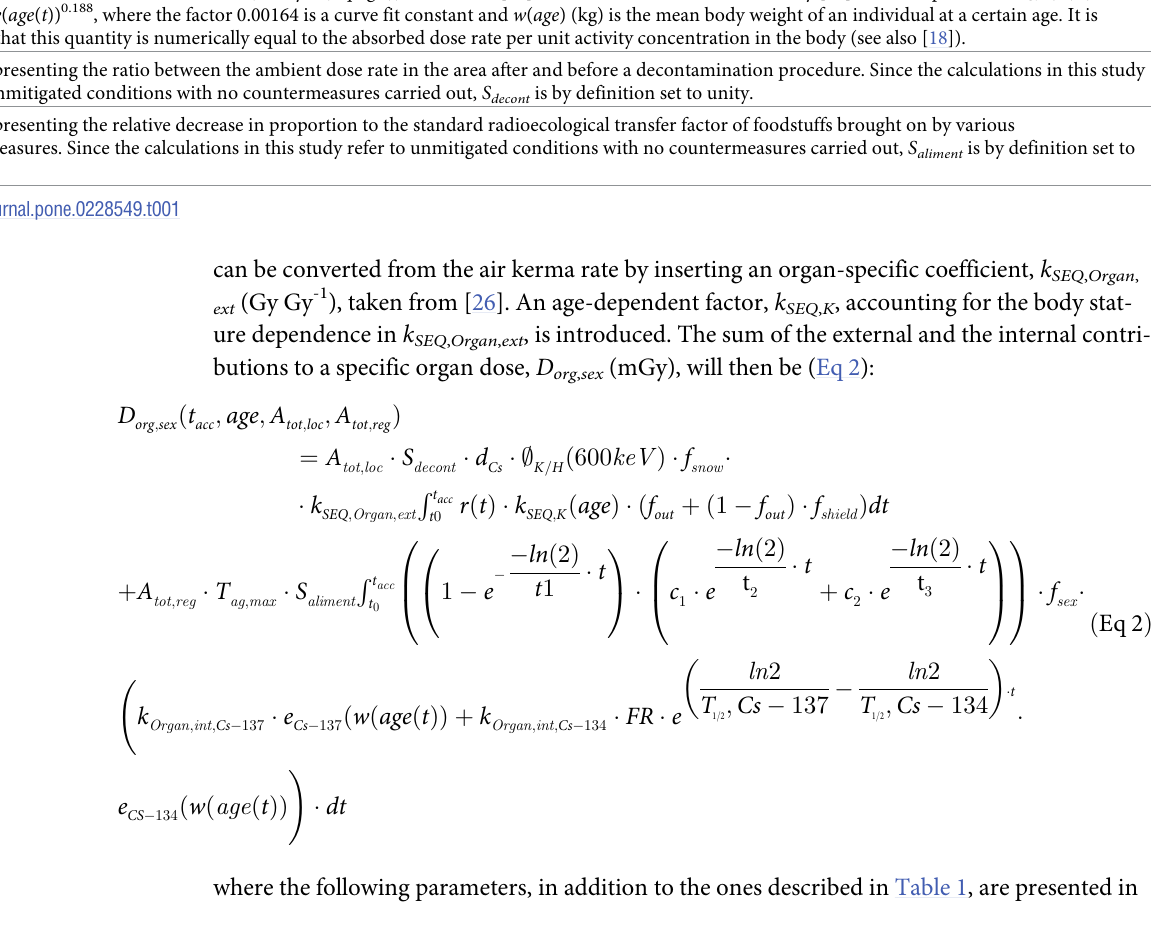
Table 2. Parameter values used for calculation of organ-absorbed doses (Eq (2)). Parameter Description